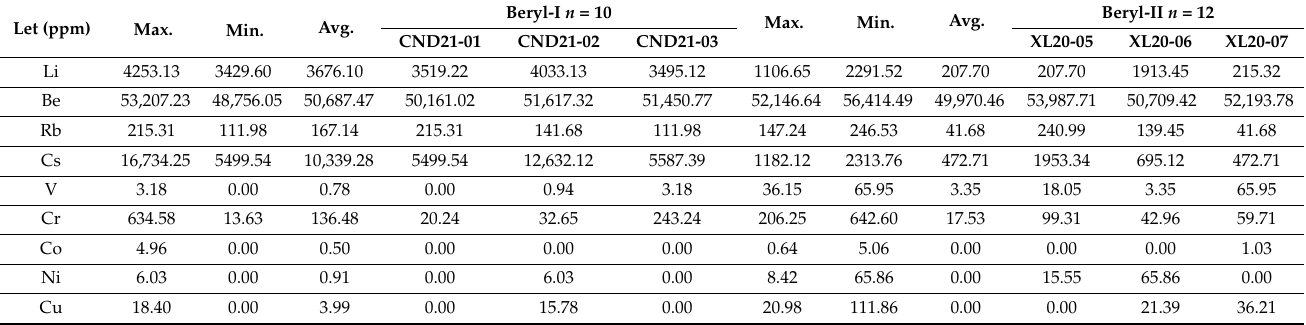
Table 2. Representative trace element compositions of beryls from the Xianglin area, as determined through